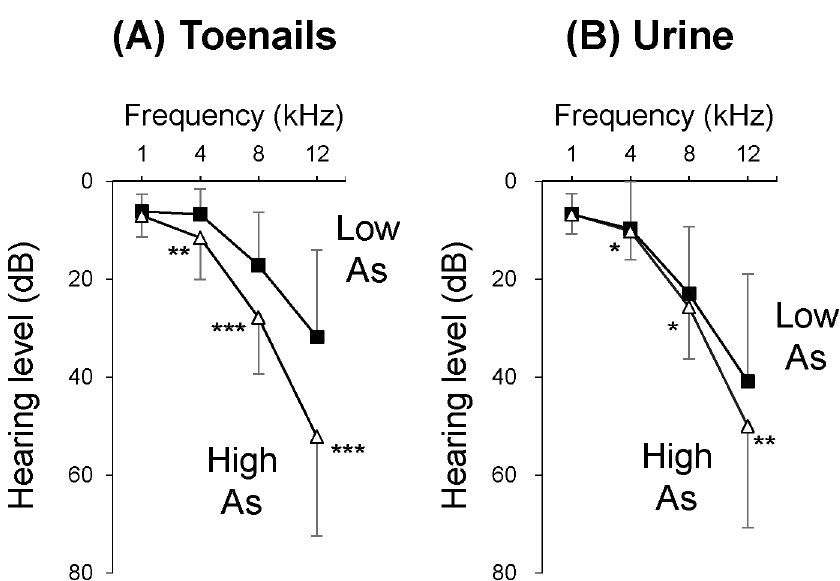
Fig 1. Association between hearing thresholds and As levels in biological samples in humans. (A) Hearing levels (mean ± SD) at 1, 4, 8 and 12 kHz in the high As group ( (cid:21) 0.60 μ g/g; n = 97) and low As group ( < 0.60 μ g/g; n = 48) in toenails are presented. (B) Hearing levels (mean ± SD) at 1, 4, 8 and 12 kHz in the high As group ( (cid:21) 76.12 μ g/L; n = 73) and low As group ( < 76.12 μ g/L; n = 72) in urine samples are presented. Significant differences ( (cid:3) p < 0.05; (cid:3)(cid:3) p < 0.01; (cid:3)(cid:3)(cid:3) p < 0.001) were determined by the Mann-Whitney U test.